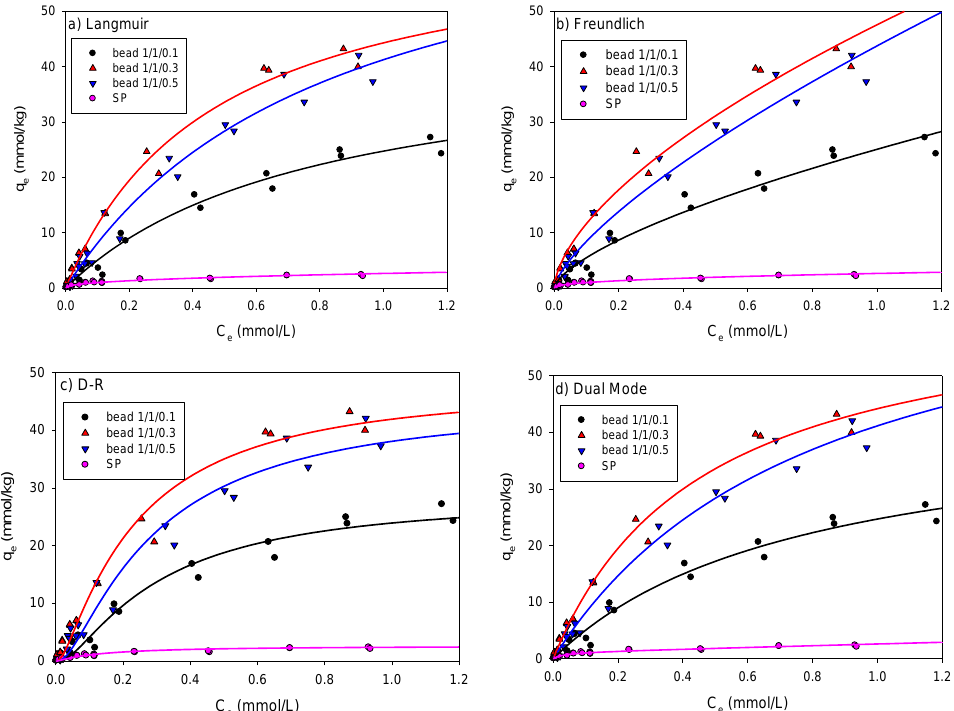
Figure 4. Nonlinear fitting of the ( a ) Langmuir; ( b ) Freundlich; ( c ) D-R; and ( d ) DM models for As adsorption onto the SCM beads and SP.